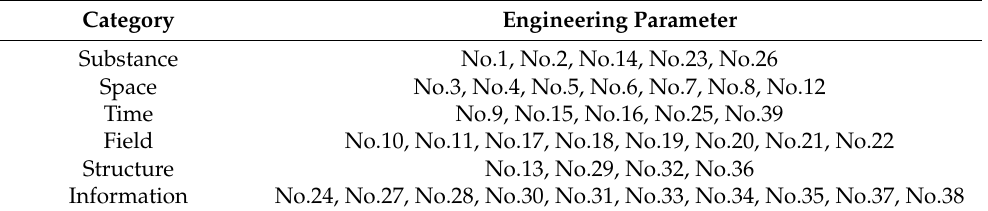
Table 3. The relationship between engineering parameters and resources.